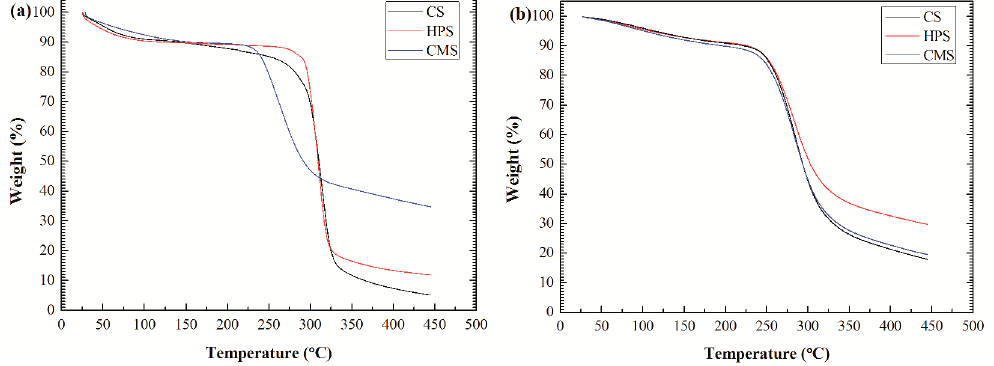
Figure 6. TGA curves for starches; ( a ) non-treated starches, ( b ) filtrate-treated starches.